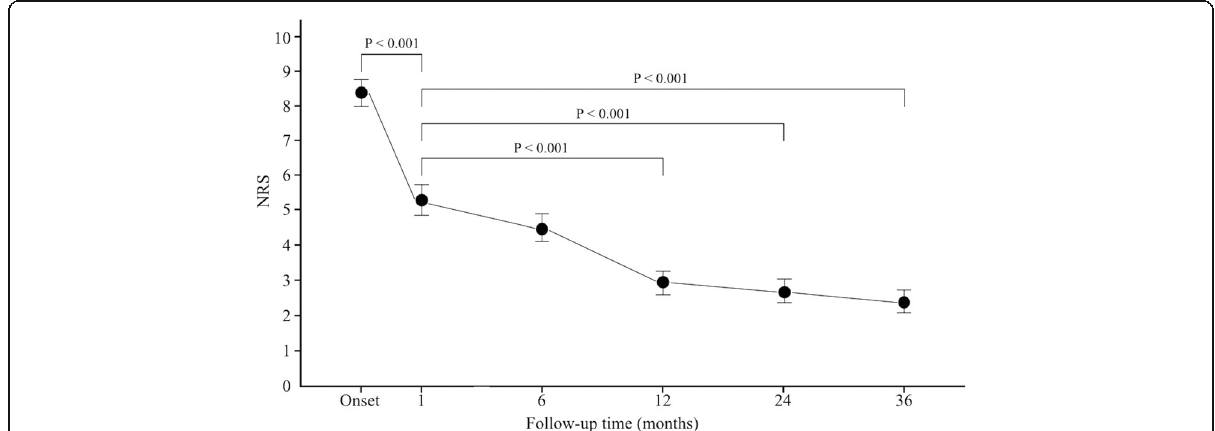
Fig. 1 The course of headache in patients with mild traumatic brain injury is represented by changes in numeric rating scale (NRS) score from onset to 36-month follow-up. Compared with NRS scores at onset, those at 1-month follow-up were significantly decreased. Follow-up NRS scores were significantly lower at 12-, 24-, and 36-month follow-ups compared to 1-month follow-up. The NRS scores decreased continuously until 36-month follow-up. Dots indicate mean NRS scores at each time point and error bars indicate the 95% confidence